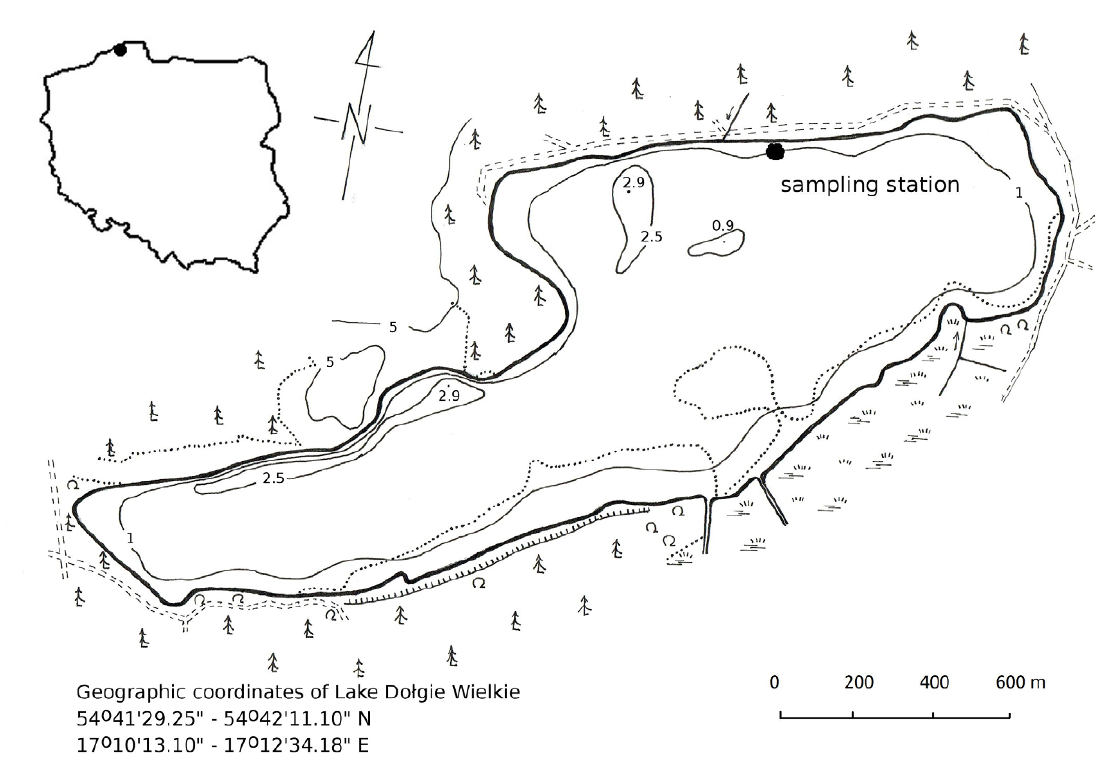
Figure 1. Localization of sampling station on lake Dołgie Wielkie (contour map of Poland on the